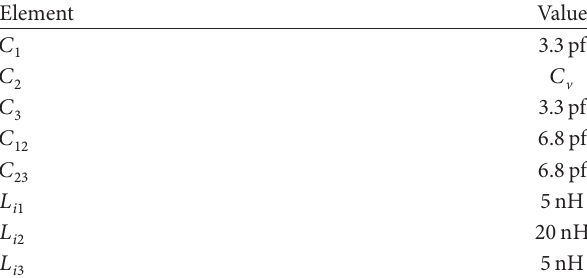
Figure 2: Lumped element equivalent circuit. Table 1: Equivalent circuit element values.